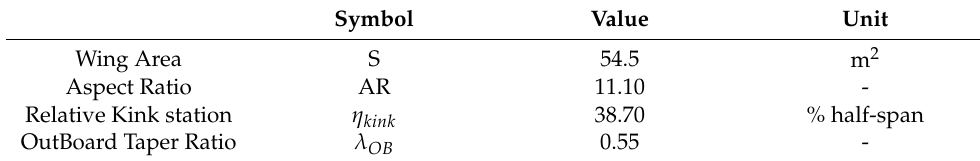
Figure 1. Analyzed configuration, three-views. Table 1. Wing planform